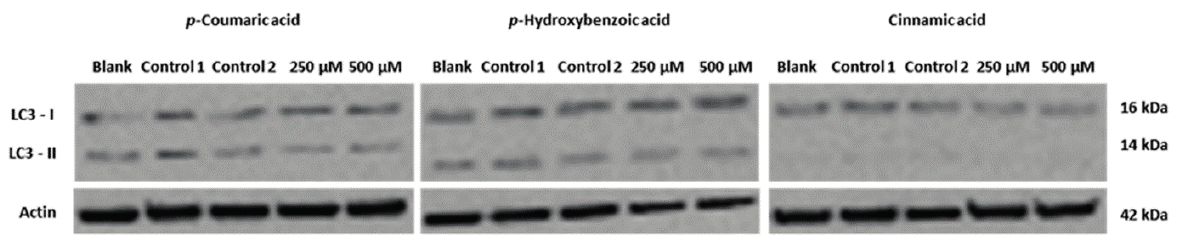
Figure 5. Analysis of the levels of the autophagy marker LC3II in AGS cells following 48 h treatment with p -coumaric acid, p -hydroxybenzoic acid or cinnamic acid, analyzed by Western blot. Cells were treated for 48 h with medium (Blank), with the solvent (DMSO:water; 1:1 v / v ; controls 1 and 2) or with the compounds (at 250 and 500 µM). Actin was used as loading control. Blot is representative of two independent